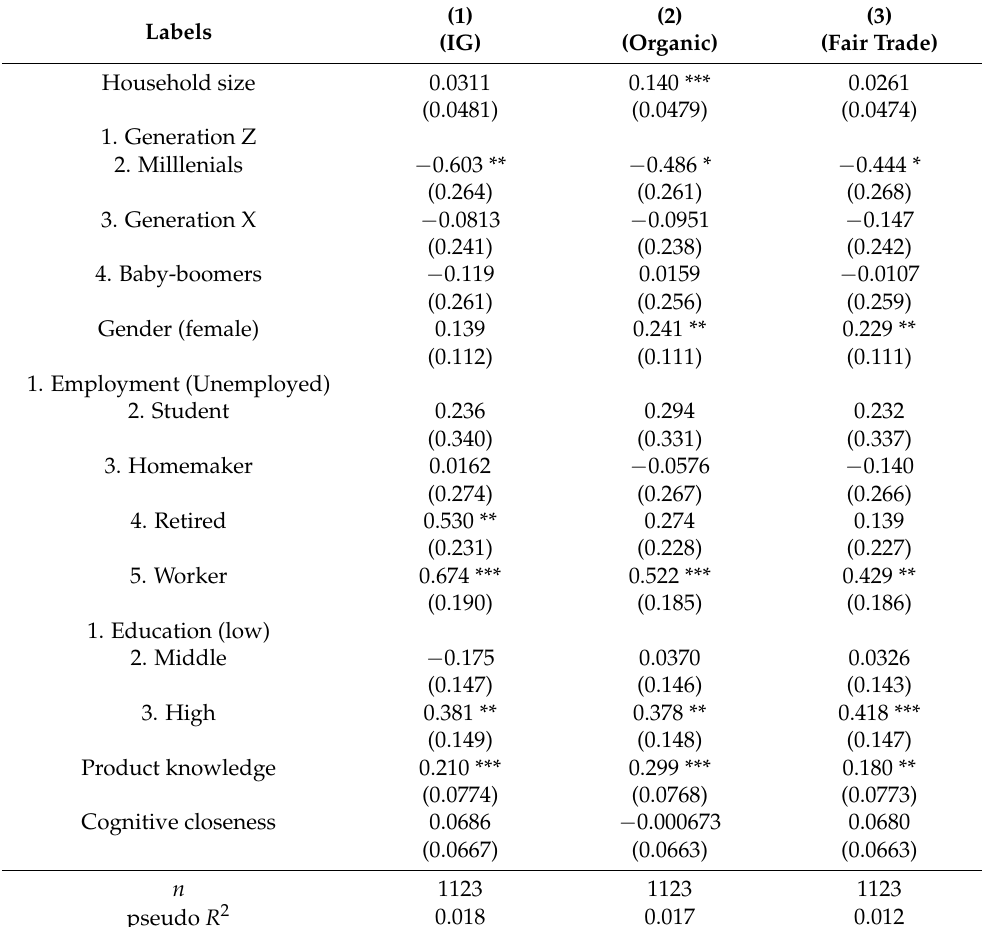
Table 5. Ordered logistic regression for the willingness to pay according to the